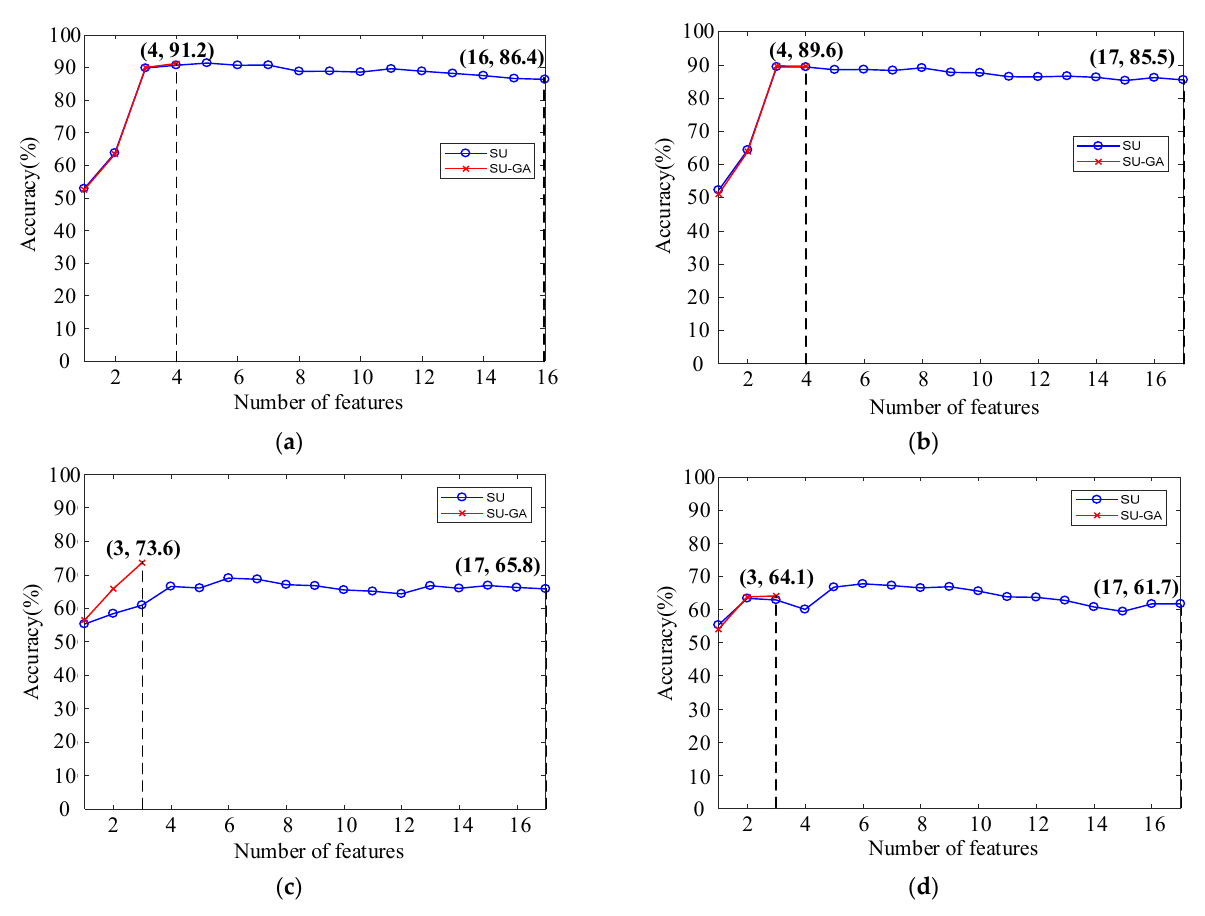
Figure 11. ( a ) Relationship between number of features and accuracy, ( b ) relationship between number of features and accuracy (40 dB), ( c ) relationship between number of features and accuracy (30 dB), and ( d ) relationship between number of features and accuracy (20 dB).